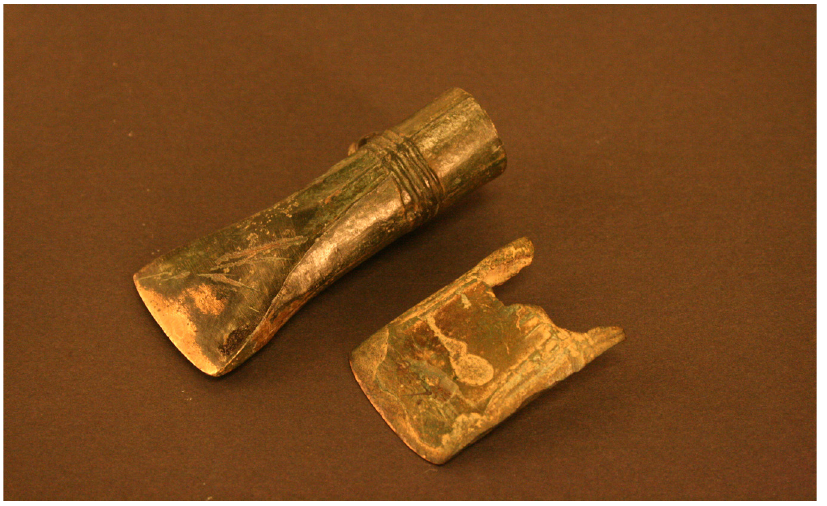
Figure 6: A Mälar axe and an Ananino axe found in the province of Uppland, in middle Sweden. These two types of bronze axes have been connected with the Volga-Kama region in Russia, and have played important roles in discussions on eastern contacts in middle and northern Sweden. Photo by authors. Photo courtesy of Museum Gustavianum, Uppsala